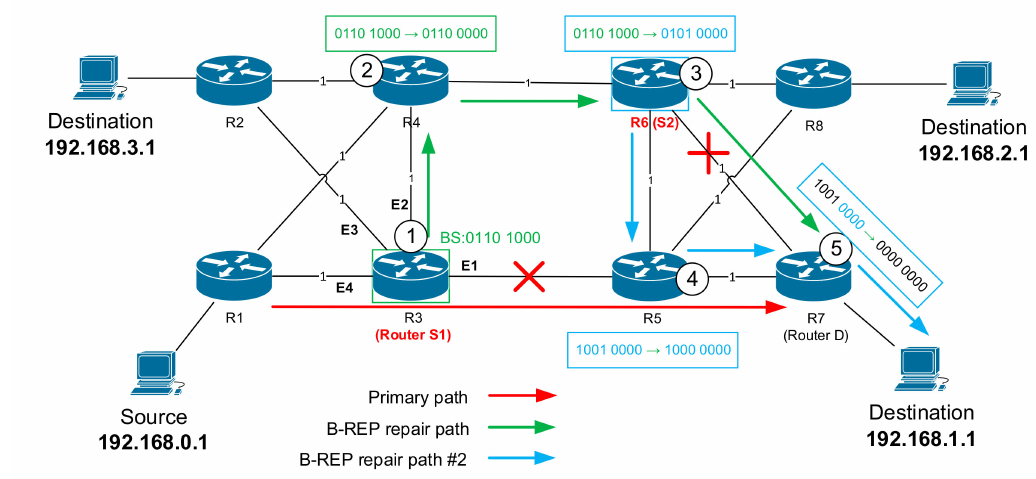
Figure 9. The principle of